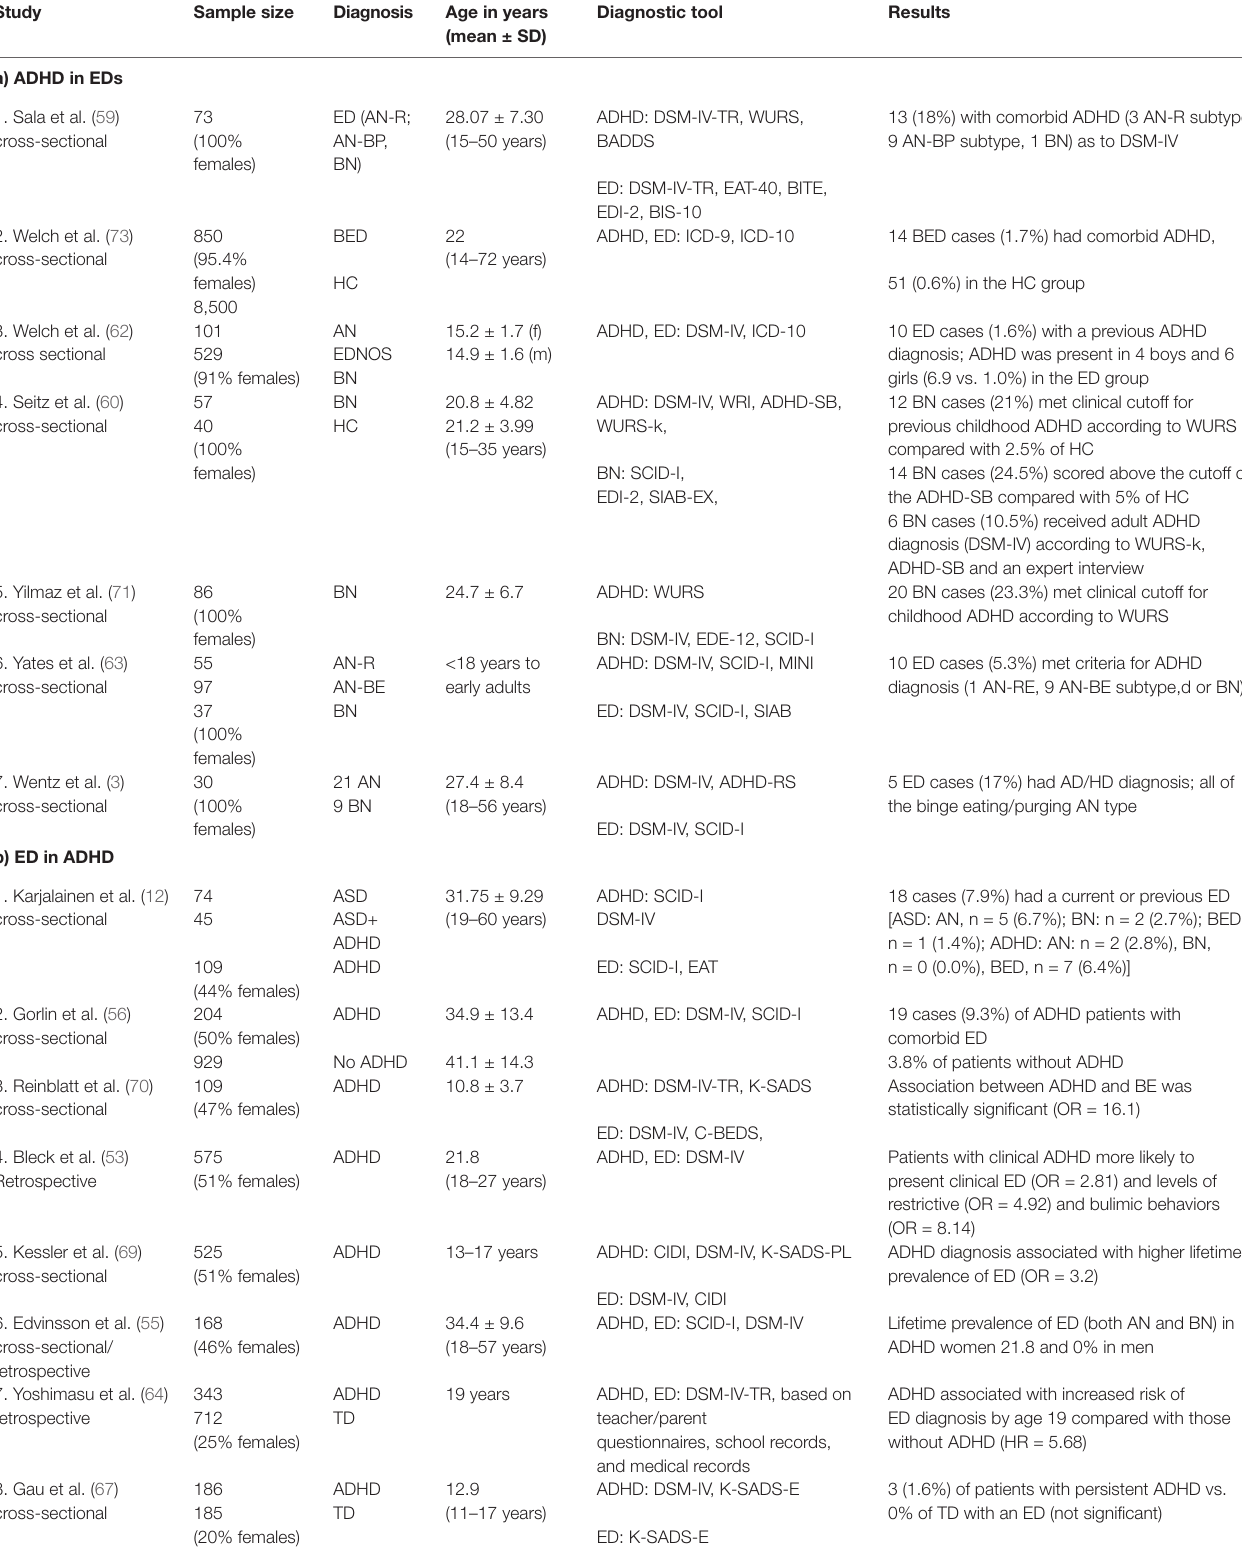
TABLE 3 | Previous prevalence studies in patients with EDs (AN, BN, BED) and